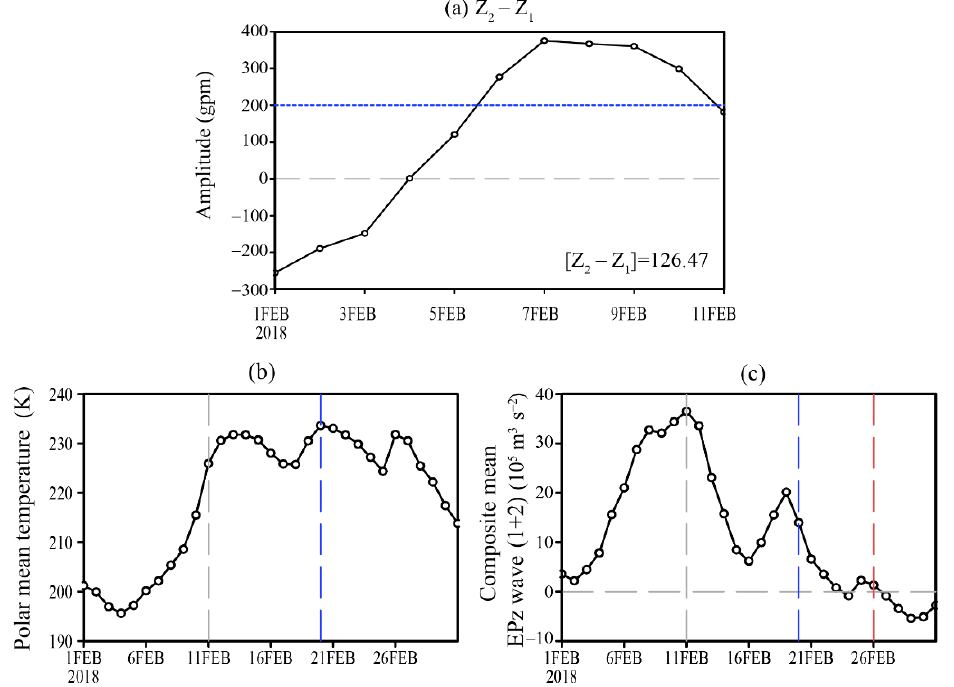
Figure 6. Temporal evolutions of ( a ) the difference of geopotential height at 50 hPa along 60° N between wavenumber-1 and wavenumber-2 component, ( b ) the temperature averaged in the polar region (0 – 360°, 70° – 90° N) at 50 hPa, and ( c ) composite means of the EP z flux associated with wavenumber 1 and wavenumber 2 in 45° – 75° N at 100 hPa. Blue dashed line in ( a ) marks the 200 gpm. Gray dashed lines in ( b , c ) represent the onset date of the 2018 SSW event. Blue and red dashed lines represent the date when the maximum temperature in the polar region appears and the sixth day after it, respectively.